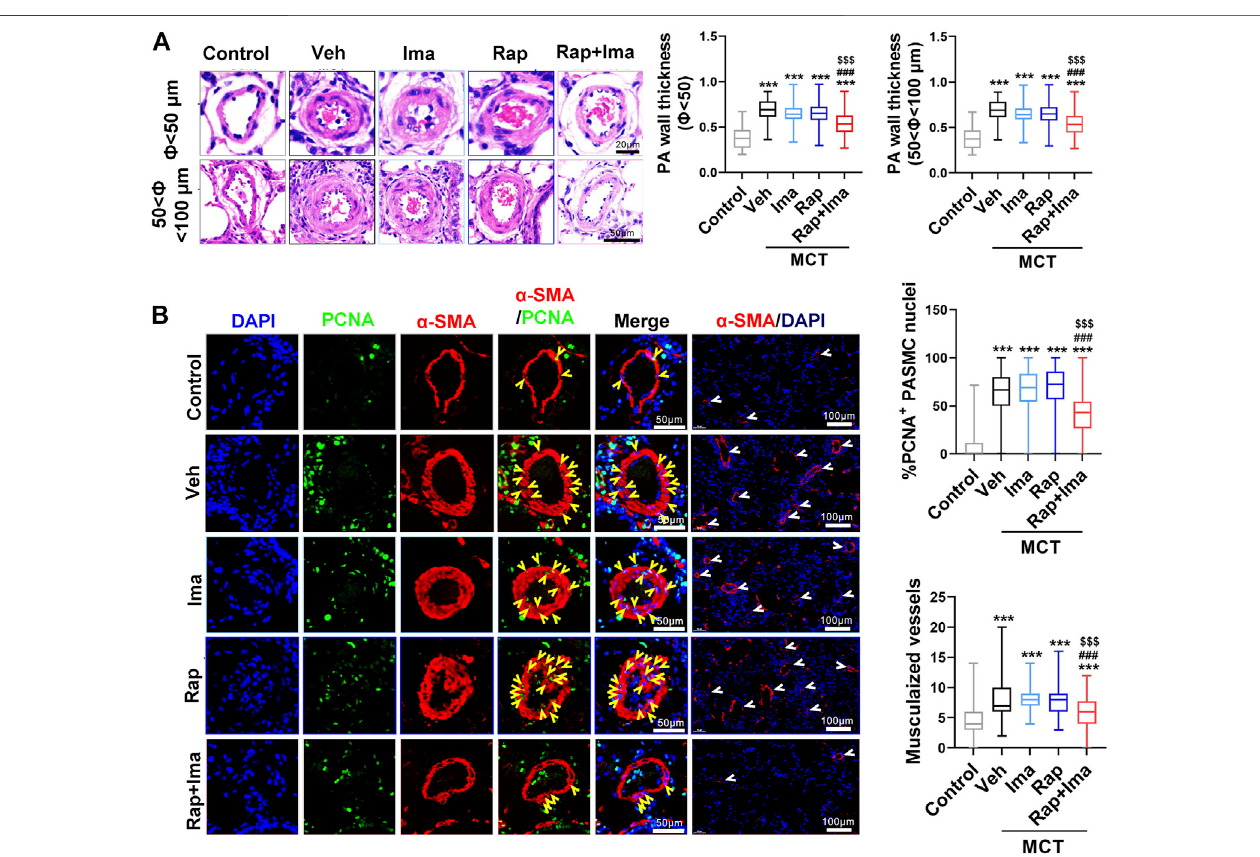
FIGURE 5 | Rapamycin combined with imatinib attenuates PASMC proliferation and remodeling induced by MCT. (A) H&E staining in lung tissue sections. Summarized data showing pulmonary artery media wall thickness. (B) Lung sections were stained α -SMA (red) and PCNA (green). Yellow arrowheads point at PCNA positivePASMCs and whitearrowheadsshowthe vessels.Foreach ofthe 5groups, approximately600PASMC nuclei and 100 fi eldswere analyzed. Summarized data showing PCNA positive cells and muscularization. Data are presented as the mean ± SE. One-way ANOVA was used for statistical analysis. *** p < 0.001, ** p < 0.01, * p < 0.05 versus control; ### p < 0.001, ## p < 0.01, # p < 0.05 versus MCT with vehicle; $$$ p < 0.001, $$ p < 0.01, $ p < 0.05 versus MCT with